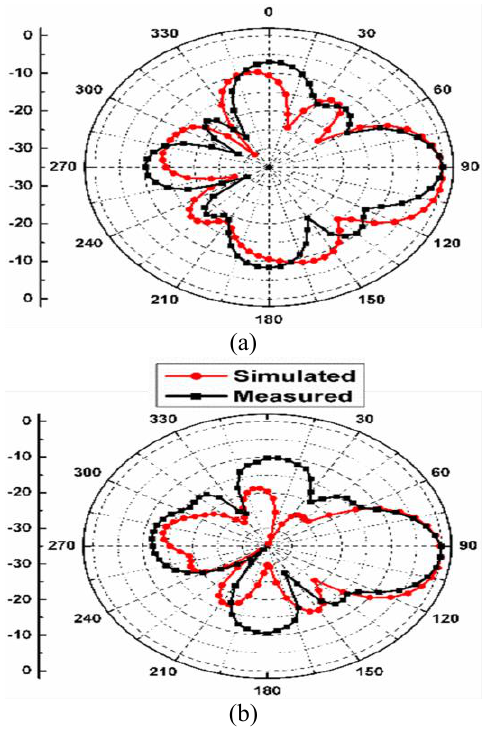
Figure 6: Radiation pattern in azimuth plane for case 1